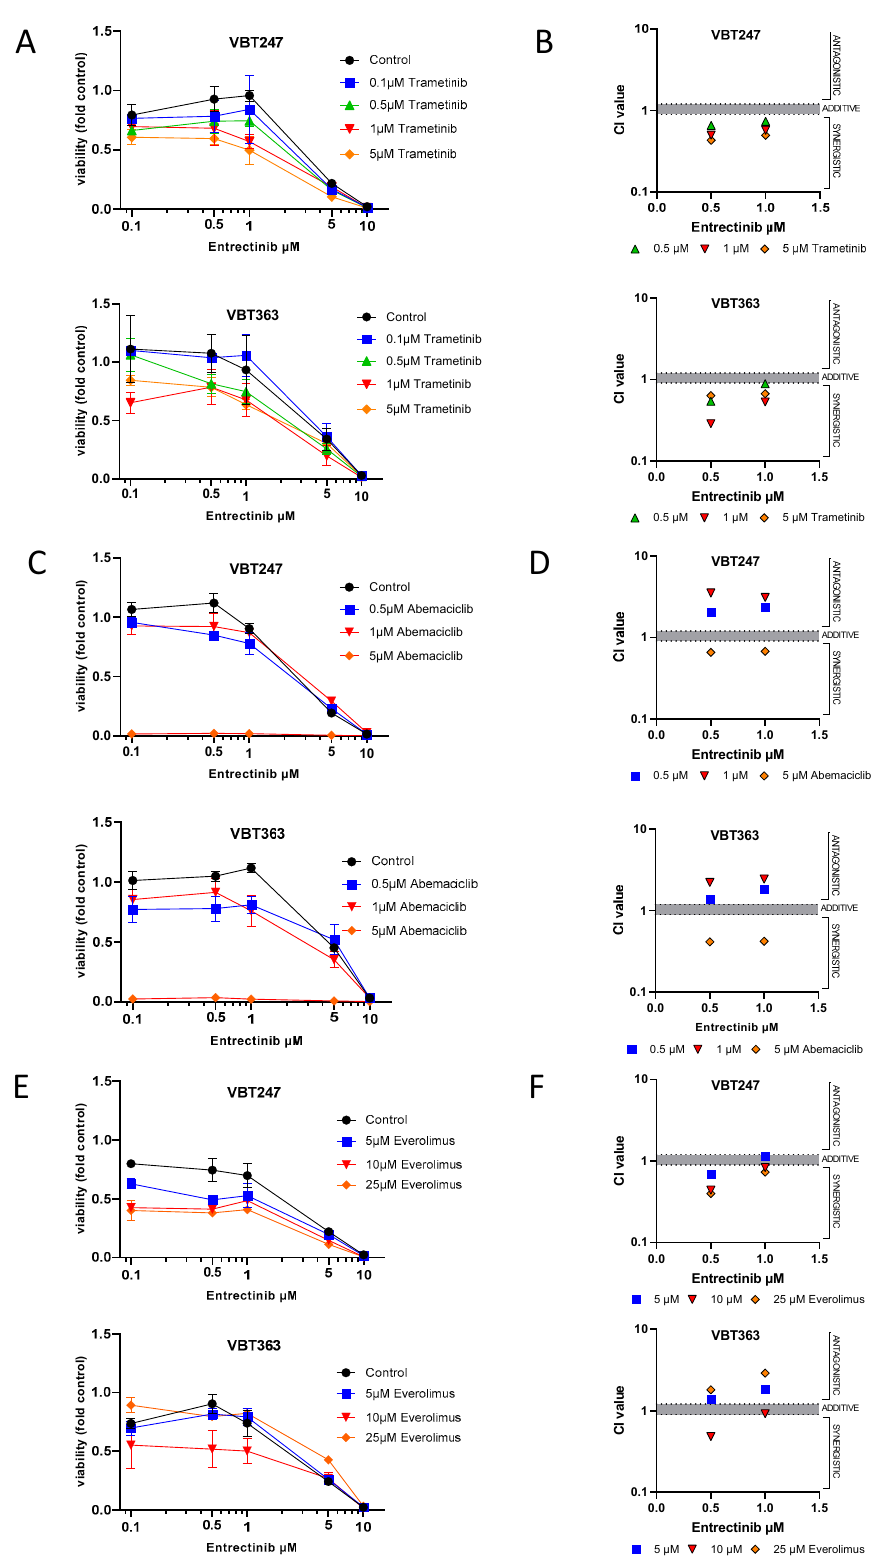
Figure 5. E ff ect of entrectinib and combination treatment on cell viability and toxicity. Impact of entrectinib treatment in combination with ( A ) trametinib, ( C ) abemaciclib, ( E ) everolimus on cell viability in triplicates in the indicated cell models measured by ATP-based survival assays upon 72 h drug exposure. Combination index (CI) based on the distinct drug combinations ( B ) trametinib, ( D ) abemaciclib, ( F ) everolimus were calculated as published [20]. CI values < 0.9 indicates synergistic, CI = 0.9–1.2 additive and CI > 1.2 antagonistic e ff